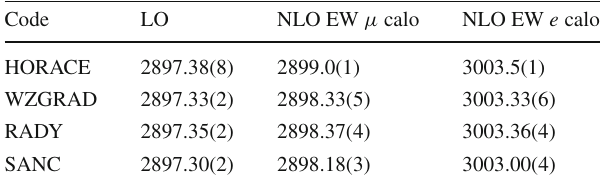
Table 4 Tuned comparison of total cross sections (in pb) for pp → W + → l + ν l + X at the 8 TeV LHC, with ATLAS/CMS cuts and